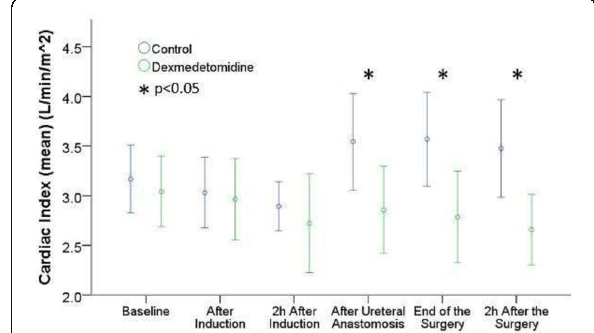
Fig. 1 (abstract 0064). Cardiac index in the two groups at different time points